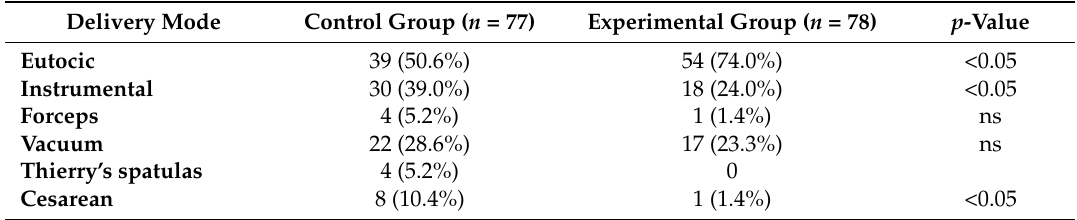
Table 3. Differences in mode of delivery between